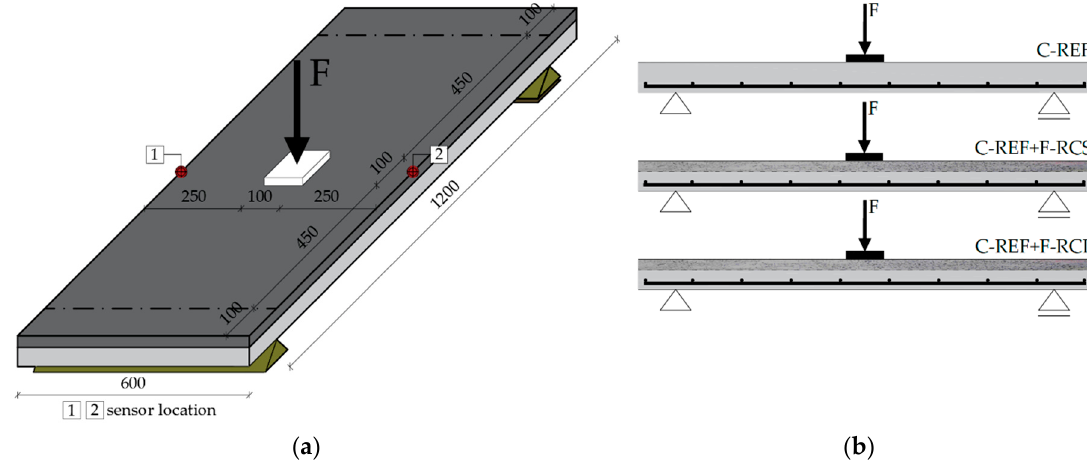
Figure 6. Bending resistance test—scheme of the tested slabs: ( a ) cavalier perspective; ( b ) cross-section.